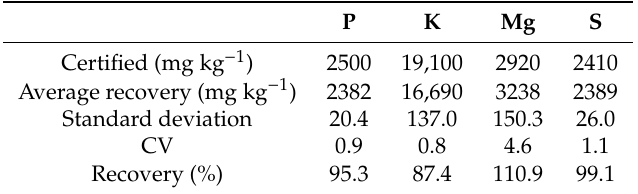
Table 3. Recovery of the certified reference material run with EDXRF